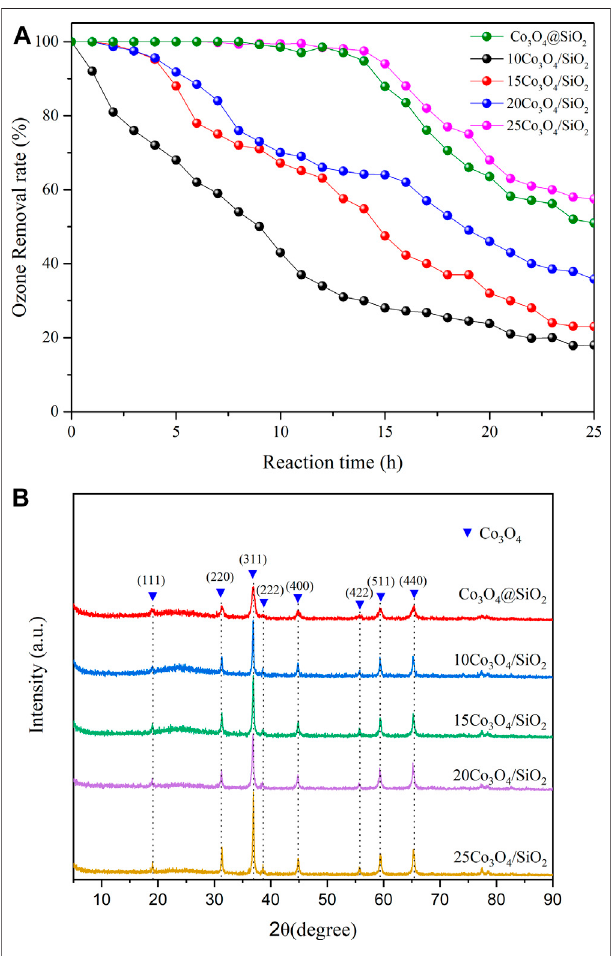
FIGURE 4 | (A) Ozone removal rates and (B) XRD patterns of Co 3 O 4 @ SiO 2 and xCo 3 O 4 (x (cid:1) 10, 15, 20, and 25). Temperature (cid:1) 25 ° C; relative humidity (cid:1) 20%.